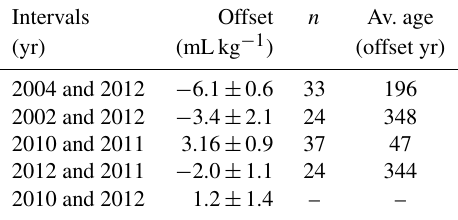
Figure 4. GRIP TAC data (Raynaud et al., 1997) in brown, vacuum- melt TAC data in yellow and melt–refreeze TAC data in blue. All data on the synchronized ice age scale for GRIP and NGRIP are according to Seierstad et al. (2014). The black curve at the bottom represents the difference between GRIP and NGRIP TAC data in 2kyr intervals.